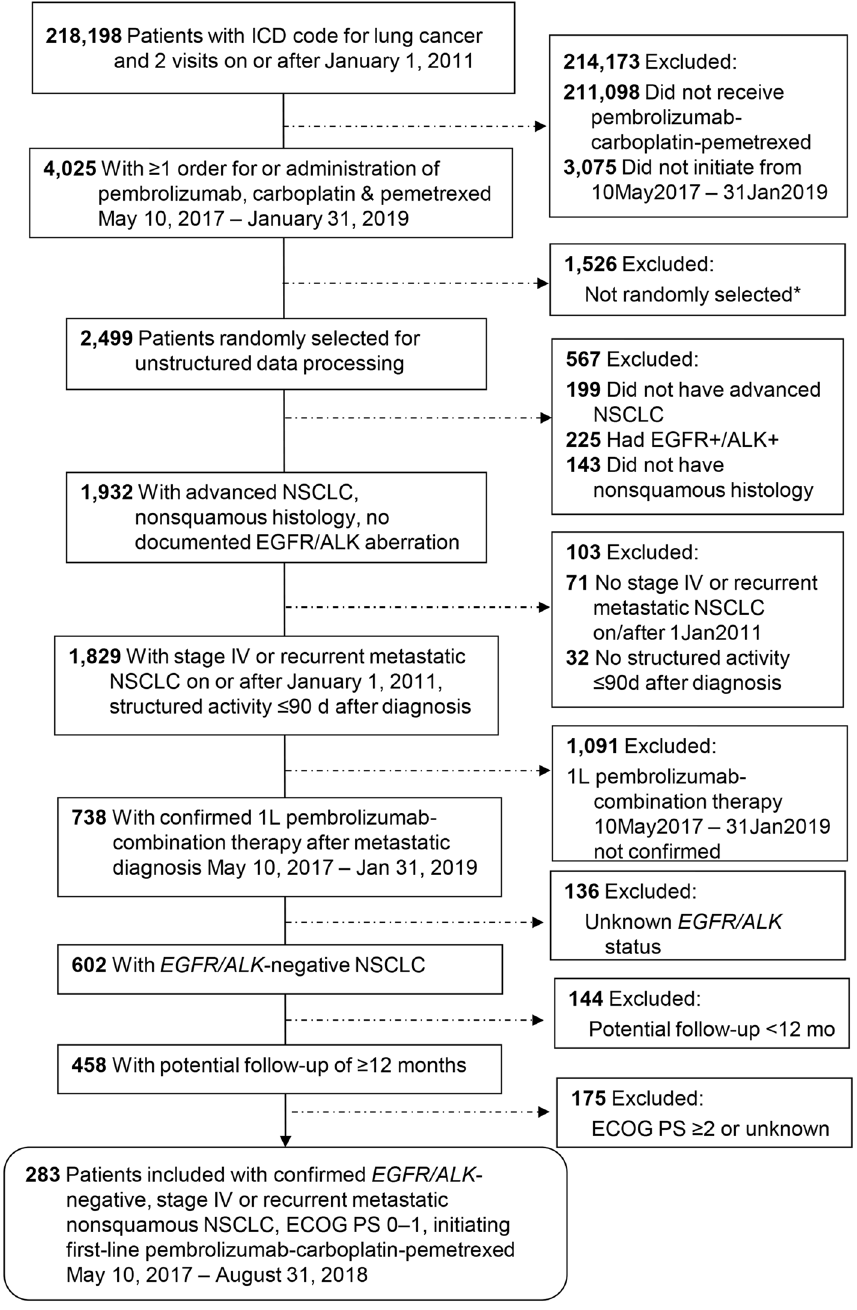
Figure 1. Patient selection from the Flatiron Health advanced NSCLC database. *1526 patients were excluded when the cohort of 2,499 patients was randomly selected from 4,025 patients for the application of further eligibility criteria via unstructured data processing (enhanced manual chart review). ALK anaplastic lymphoma kinase gene translocation, ECOG Eastern Cooperative Oncology Group performance status, EGFR epidermal growth factor receptor gene mutation, ICD international classification of diseases, NSCLC non-small cell lung